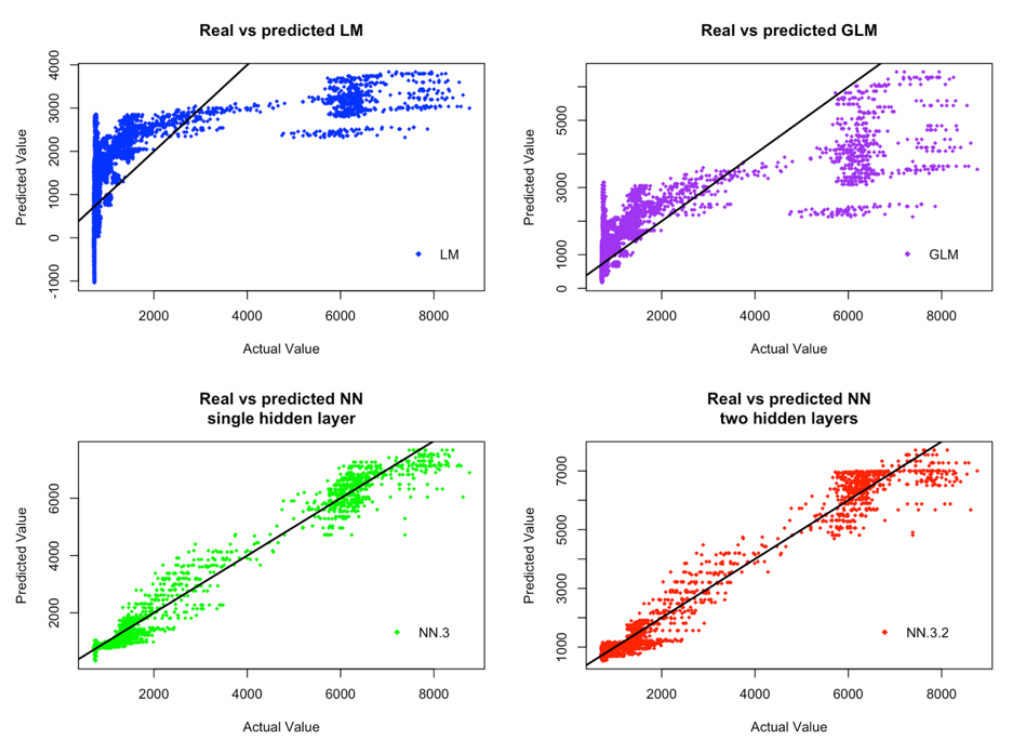
Figure 5. Plots of actual values against predicted values of numbers of IWDs at the simulation end for the four considered